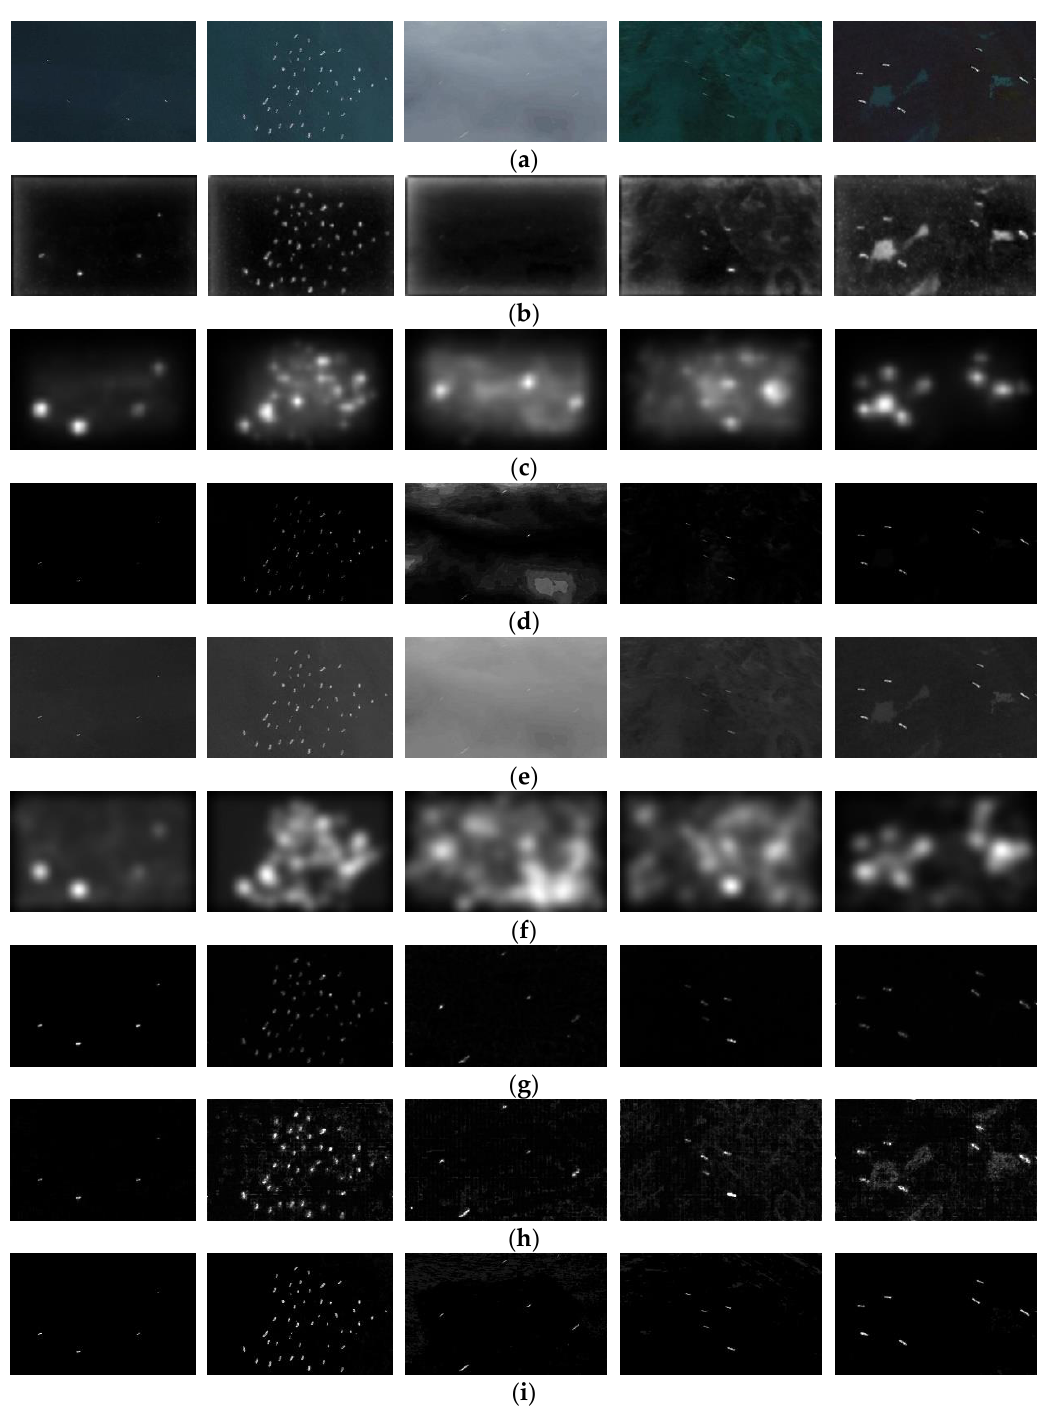
Figure 1. Comparison of several saliency detection method: ( a ) original images; ( b ) ITTI; ( c ) graph-based visual saliency (GBVS); ( d ) spectral residual (SR); ( e ) histogram contrast (HC); ( f ) Principal Component Analysis (PCA); ( g ) phase quaternion Fourier transform (PQFT); ( h ) hypercomplex Flourier transform (HFT); ( i ) proposed method.